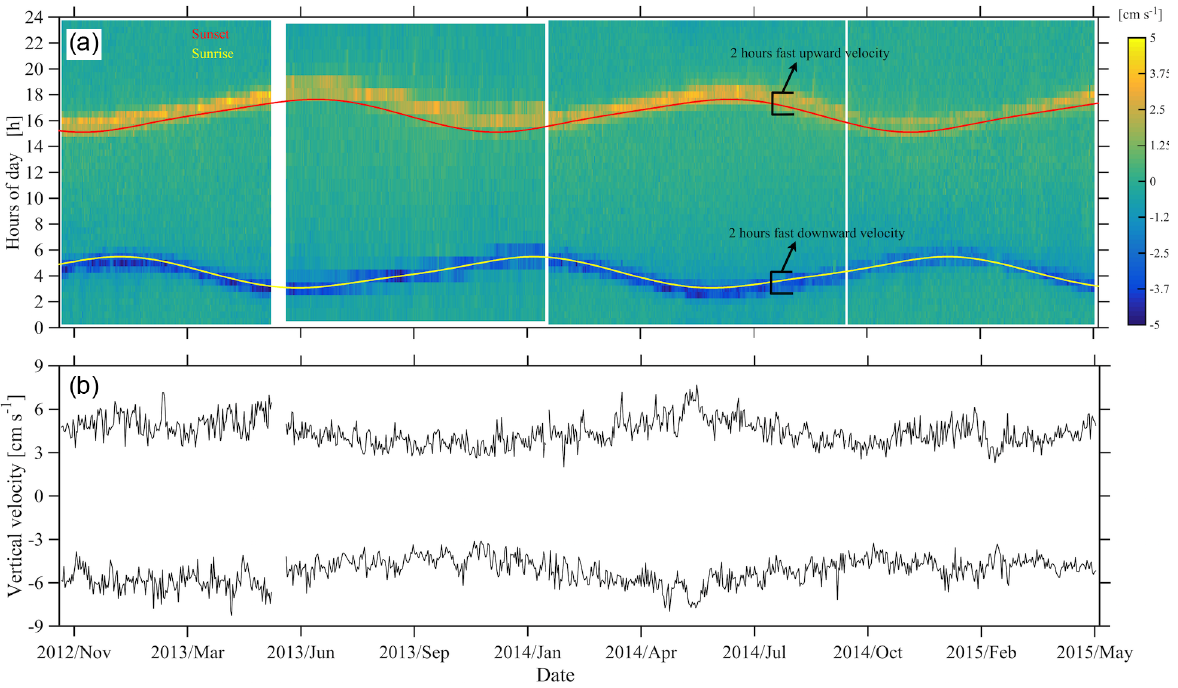
Figure 8. Instantaneous depth-averaged vertical velocities of daily segments of ADCP measurements between 350 and 50m (a) , following Jiang et al. (2007). Sunrise and sunset times are superimposed. Average of the three highest upward and downward velocity values per day (b) . The hours of fast zooplankton motion are also